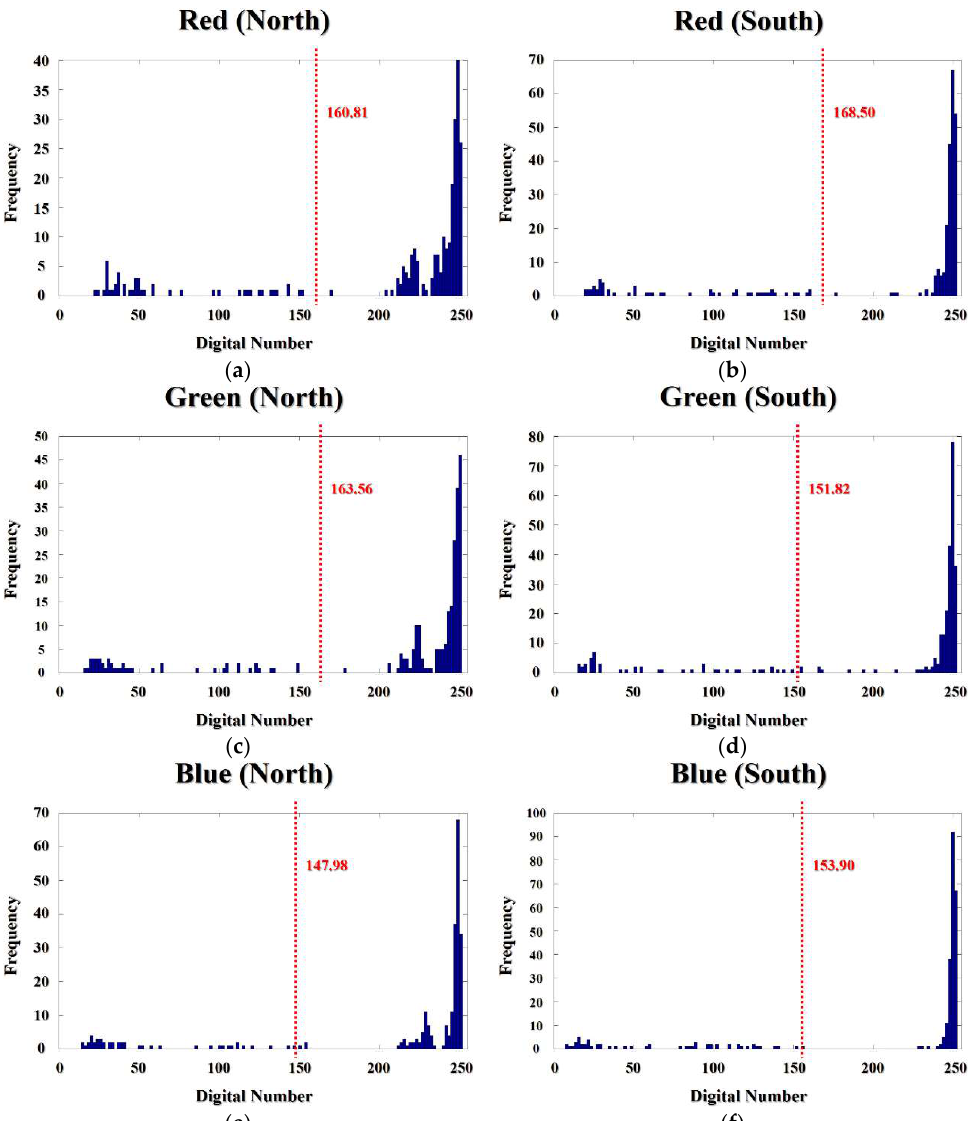
Figure 7. Histograms of cotton boll candidates. Red bands of ( a ) north and ( b ) south sites; green bands of ( c ) north and ( d ) south sites; blue bands of ( e ) north and ( f ) south sites. The automatically calculated threshold values of red, green, and blue bands using the proposed approach were 160.81, 163.56, and 147.98 for the north site and 168.50, 151.82, and 153.90 for the south site, respectively. These threshold values were then applied to the orthomosaic images from each site to finalize the cotton boll extraction procedure. Pixels with higher digital numbers than the threshold values in each band were classified as cotton bolls. In addition, the size constraints ( 𝑠 (cid:2870) , 𝑠 (cid:2871) ) were applied to the binary classification results for noise reduction. The roundness constraint ( 𝑟 (cid:2869) ) was not used in this step because cotton bolls on the upper and lower canopy look as if they are connected in orthomosaic images due to the nadir view. Cotton boll extraction results for subsets N3 and S3 of the north and south sites are shown in Figure 8.